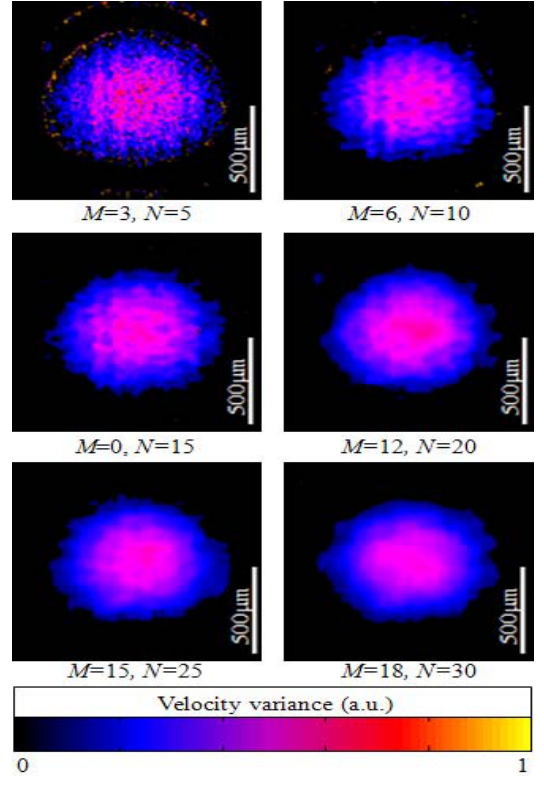
Figure 6. B-scan ODT images of flowing particles in a capillary tube with different averaging window sizes. Doppler angle: 80°. Flow velocity: 80